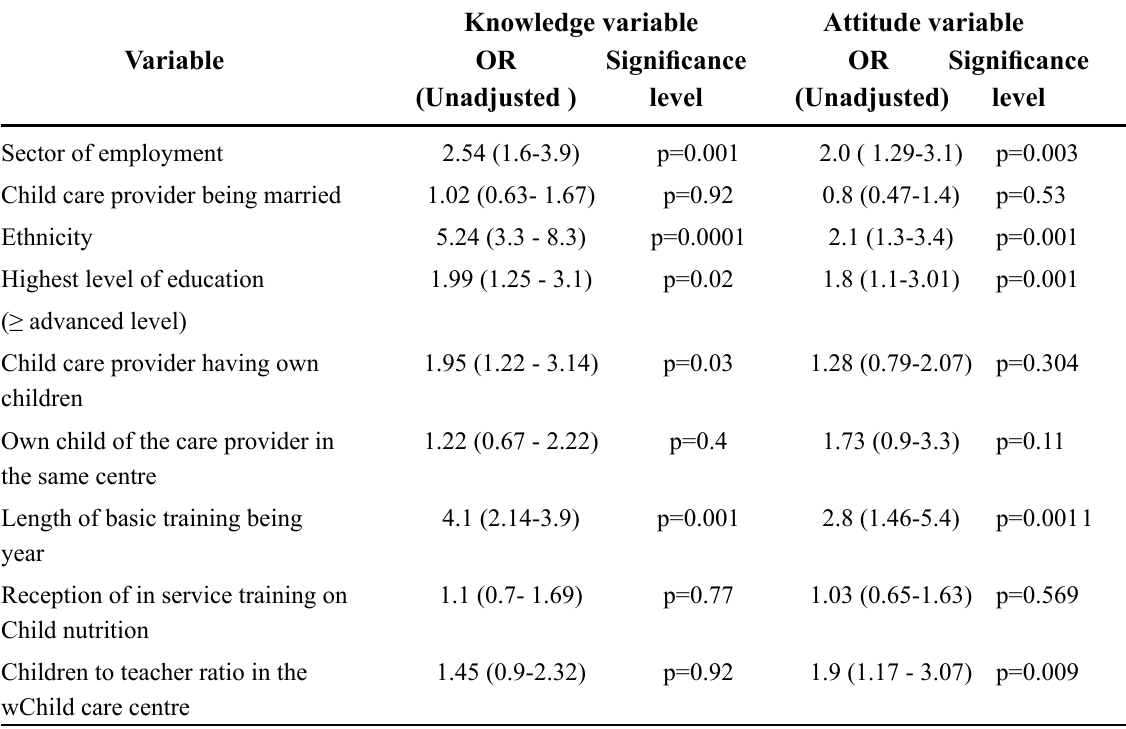
Table 3: Association between selected socio demographic factors with knowledge and